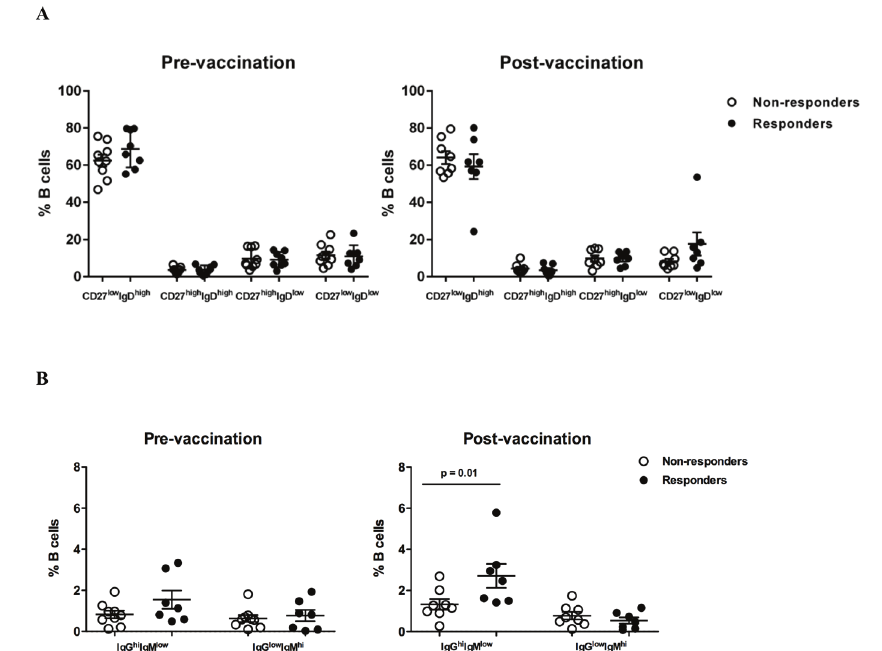
Figure 2. HBV response is associated with increased frequency of IgG high memory B cells post vaccination. (A) Pooled data showing the relative frequencies of B-cell populations, judged by the expression of CD27 and IgD, in non-responders and responders pre- and post-vaccination, (B) the relative frequencies of IgG- high IgM low switched memory (CD27 high IgD low ) B cells pre- and post-vaccination. Data presented in Figures A and B are scatterplots with mean and SEM with P -values calculated using Mann-Whitney U test. Circulating Tfh cells correlate with plasma levels of CXCL-13 in HBV